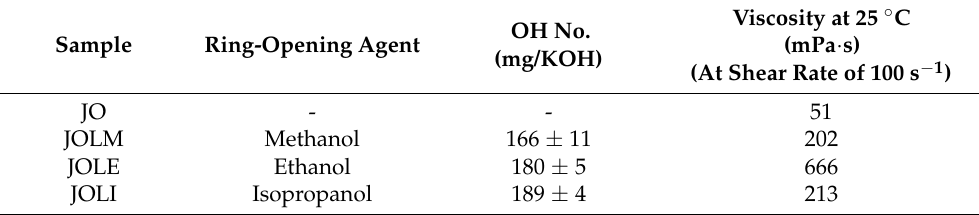
Table 2. Physicochemical properties of JO, JOLM, JOLE, and JOLI.